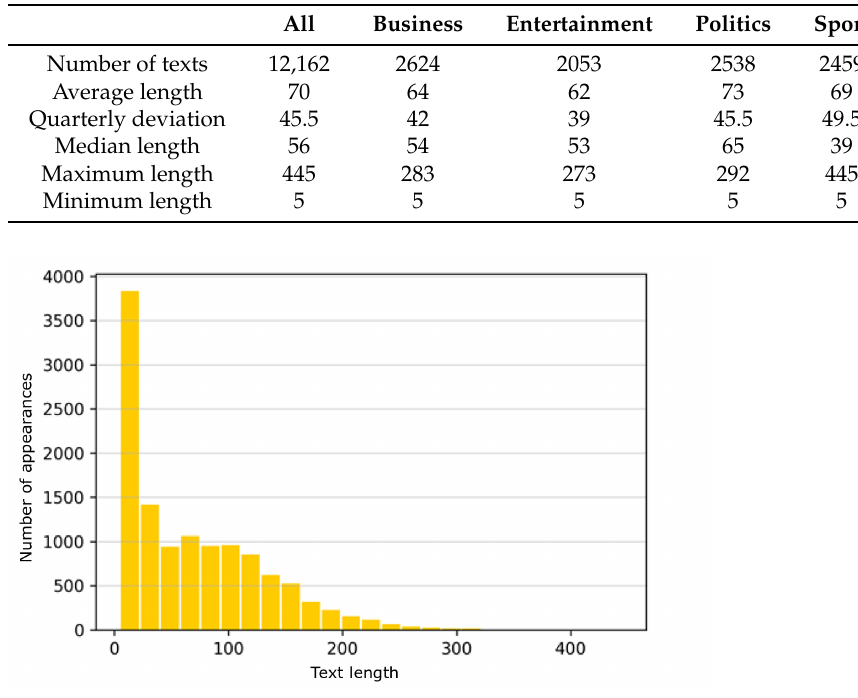
Figure 3. Summary statistics of data in studied texts—length of texts for all